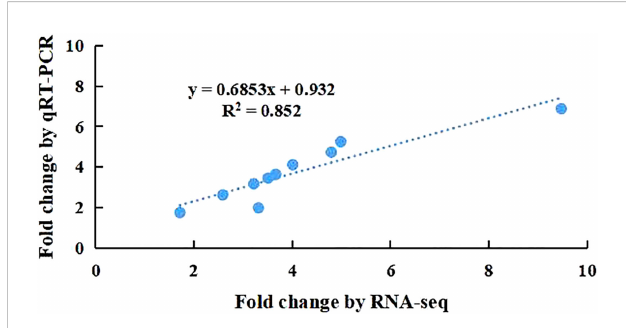
FIGURE 4 Comparison of the Fold Changes of 15 selected transcripts using RNA- Seq and qRT-PCR. Each blue point represents a chosen gene used in the validation of the RNA-Seq results.